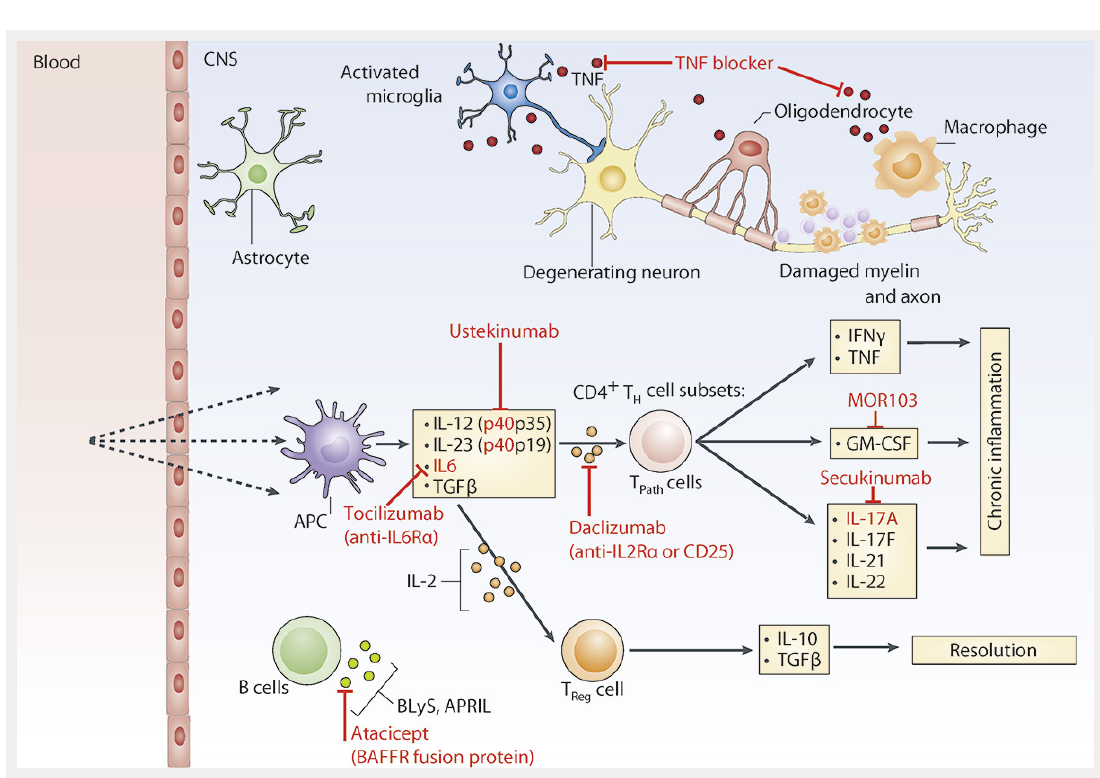
Key cytokines in the pathogenesis of multiple sclerosis. In patients with MS and in its experimental models EAE, various immune cells have been shown to produce and react to pro- and anti- inflammatory cytokines in the inflamed CNS. The main cytokines secreted by antigen-presenting cells, pathogenic CD4+ Th cell subsets and T regs are shown. Potential cytokine targets for therapy and drugs are indicated in red. TNFα is expressed by T cells but also by microglia and macrophages. Its blocking has failed in clinical MS trials possibly because it has also homeostatic effects in the CNS and is important for remyelination. Other cytokine inhibitors like ustekinumab, which targets the p40 subunit of IL-12 and IL-23, involved in the generation of pathogenic CD4+ Th cell subsets has recently been tested in clinical trials and was unexpectedly ineffective to reduce clinical relapses in MS patients. Studies with neutralizing anti-GM-CSF (MOR103), anti-IL17 (secukinumab) or anti-IL2Rα antibodies (daclizumab) are ongoing and show promising first result in the treatment of MS patients. Blocking of maturation factors of B cells (BLys, APRIL, or in the case of neuromyelitis optica IL-6Rα by tocilizumab) might be another therapeutic approach worth following up. APC = antigen-presenting cell; BAFF = B cell activation factor; CNS = central nervous system; EAE = experimental autoimmune encephalomyelitis; GM-CSF = granulocyte macrophage colony stimulating factor; IFN = interferon; IL = interleukin; MS = multiple sclerosis; T Path = pathogenic CD4+ Th cell subsets; Th = T helper cell; TNF-α = tumour necrosis factor.α; T reg = regulatory T